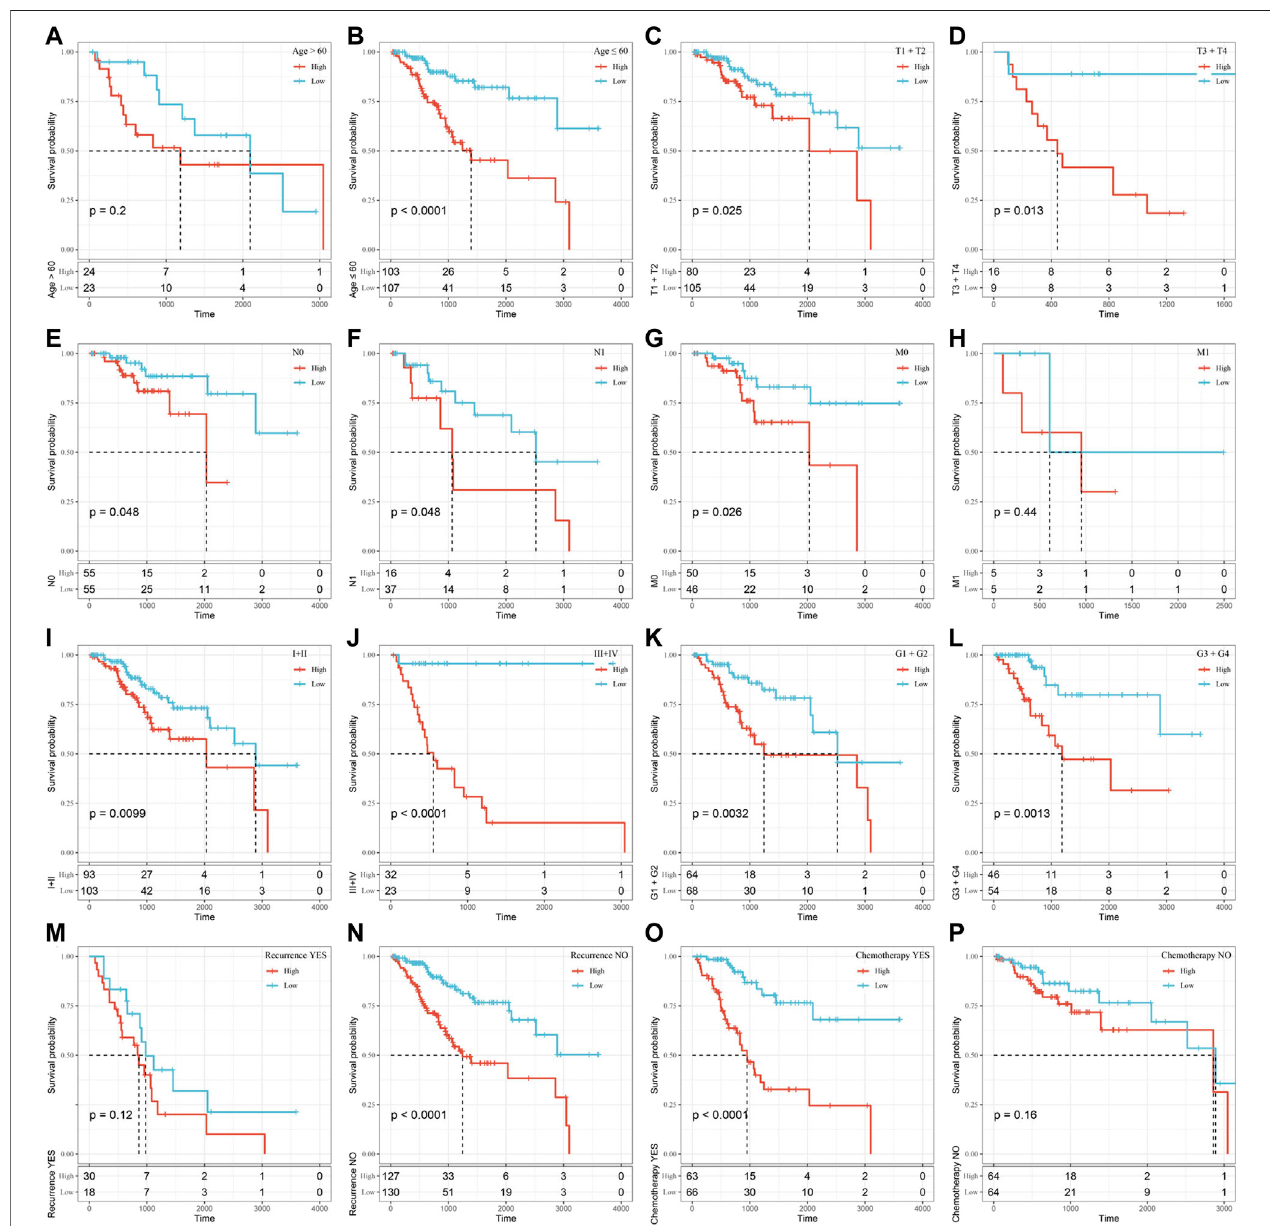
FIGURE7| AssessmentoftheOSrateofthehigh-riskandlow-riskgroupsbasedondifferentclinicalsubgroups. (A) Age > 60subgroup. (B) Age ≤ 60subgroup. (C) T1+T2 stage subgroup. (D) T3+T4 Stage subgroup. (E) N0 Stage subgroup. (F) N1 Stage subgroup. (G) M0 Stage subgroup. (H) M1 Stage subgroup. (I) Ⅰ + Ⅱ Stage subgroup. (J) Ⅲ + Ⅳ Stage subgroup. (K) G1+G2 subgroup. (L) G3+G4 subgroup. (M) Recurrence_ Yes subgroup. (N) Recurrence_No subgroup. (O) Chemotherapy _Yes subgroup. (P) Chemotherapy_No subgroup. Time: